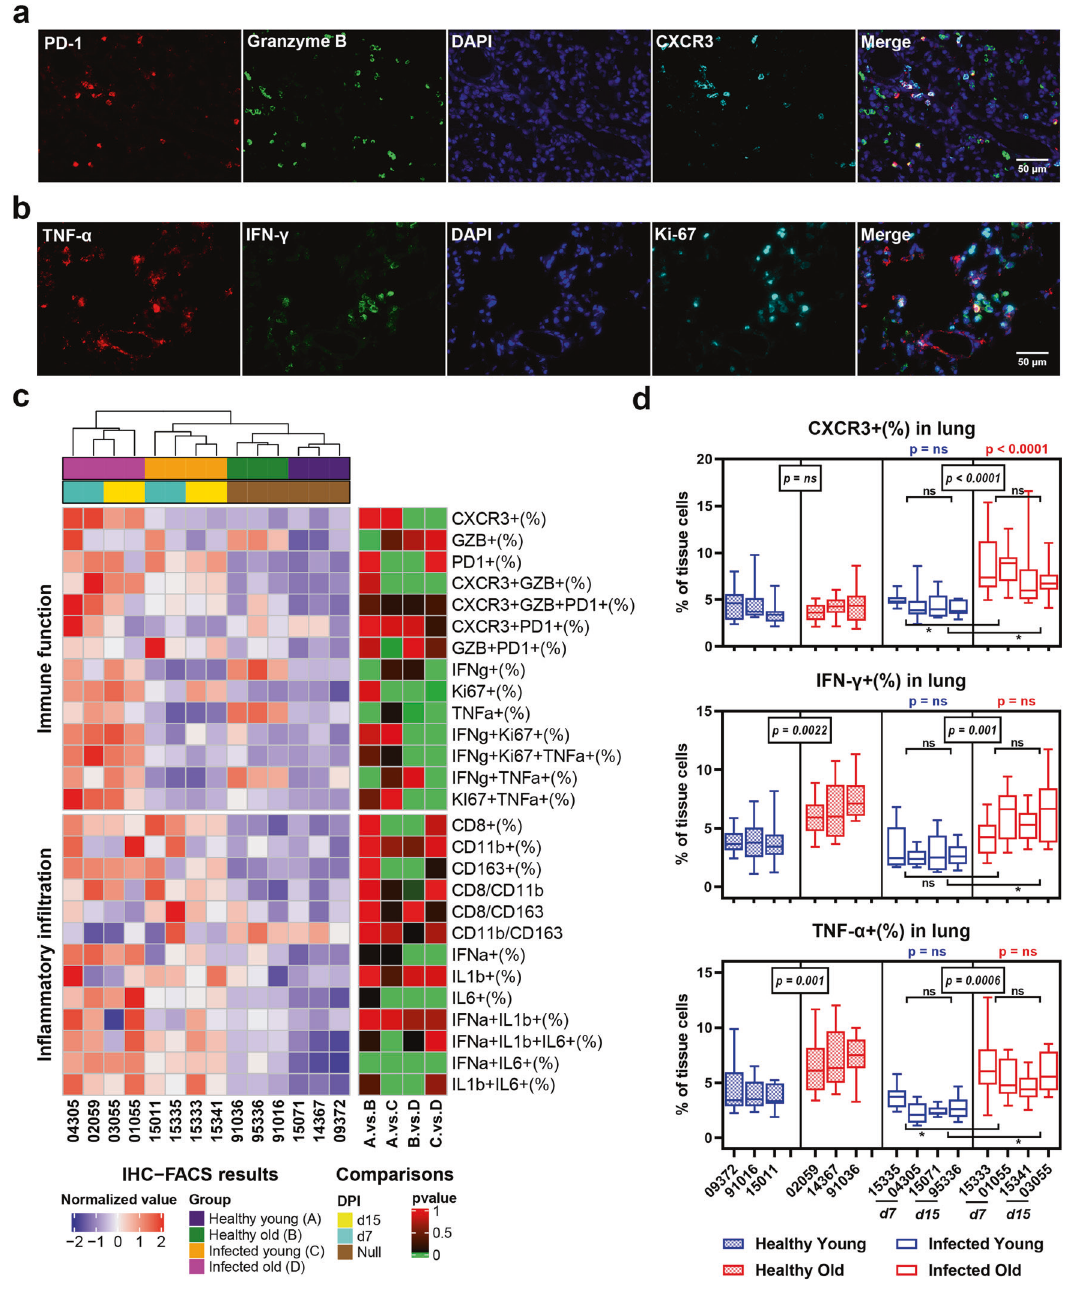
Fig. 4 Pro-in fl ammatory immune microenvironment in lung tissues of old RMs infected with SARS-CoV-2. a , b mIF images showing the co- staining results of immune function-related proteins in lung tissue sections. Red, green, and cyan indicate staining of protein markers, and blue DAPI staining indicates nucleus. c The frequency of in fl ammatory in fi ltrating cells and immune function-related cells in the lung tissue of each animal is displayed in a heat map. Annotation bar indicates group and DPI of each sample; heat map on left represents the normalized average frequency of each cell subsets by R ’ s scale method, mapped by red-white-blue gradient squares; heat map on right represents p values for comparisons between each group, and square with grass green was considered to be a statistically signi fi cant difference ( p ≤ 0.05). d Box plots showing the frequency of immune function-related cells in healthy young, healthy old, infected young, and infected old groups. Data calculated using 10 microscopy images of lung tissue sections from each animal are shown as median with min to max. P value marked in blue indicates the comparison between infected and healthy young groups, and red indicates the comparison between infected and healthy old groups. Boxed p value represents the comparison between young and old RMs in healthy (left) or infected (right) conditions. Square brackets in the fi gure show a comparison between infected young and old RMs at different time points (7 and 15 DPI). * p ≤ 0.05; ns, p > example, ORF6, which is located in the endoplasmic reticulum (ER) that direct virus infection does not fully explain the serious and Golgi membranes of infected cells, can induce apoptosis pathology found in old RMs. through caspase-3-dependent pathways and possibly through COVID-19 pathology caused by SARS-CoV-2 infection appears to phosphorylation of c-Jun N-terminal kinase (JNK) 33 . The E protein be partly based on apoptosis and autophagy of infected cells. For